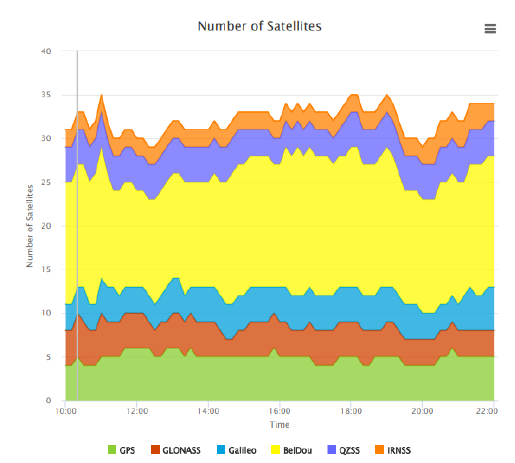
Figure 2 : Number of visible GNSS satellites above 30 0 elevation in 2022 (Test